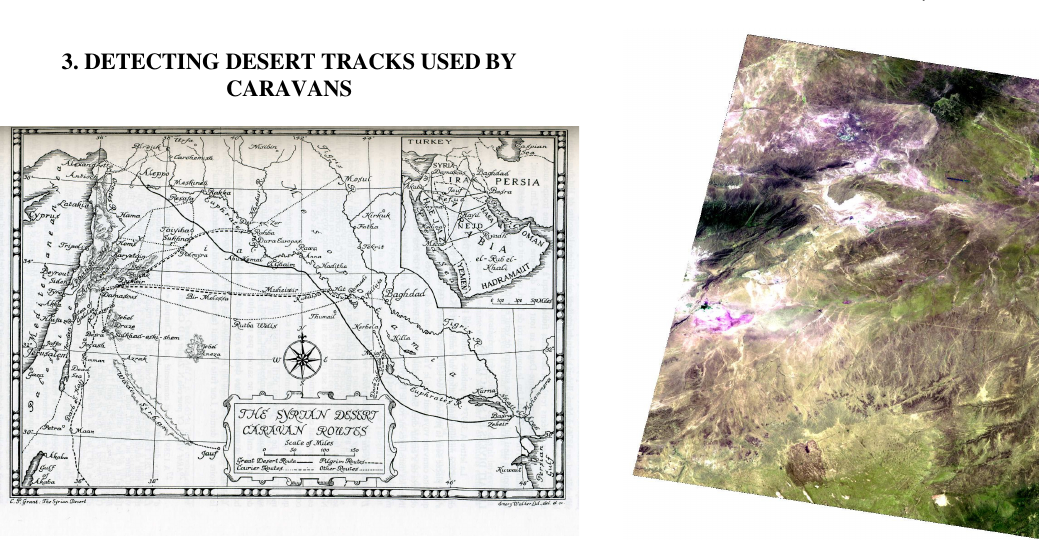
Figure 5. Landsat-2 MSS-image 185/36 (WRS-1), date 27.06.1975, channel 574.